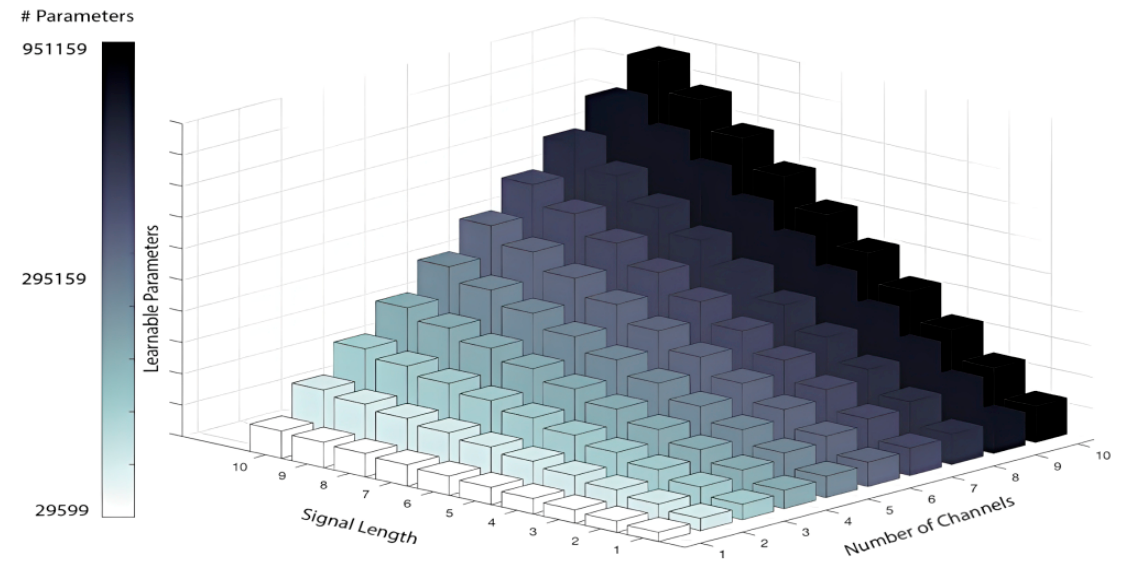
Figure 9. Number of Learnable Parameters in Terms of Signal Length and Number of Channels. Table 7. Segment Length and Number of Channels. Number of